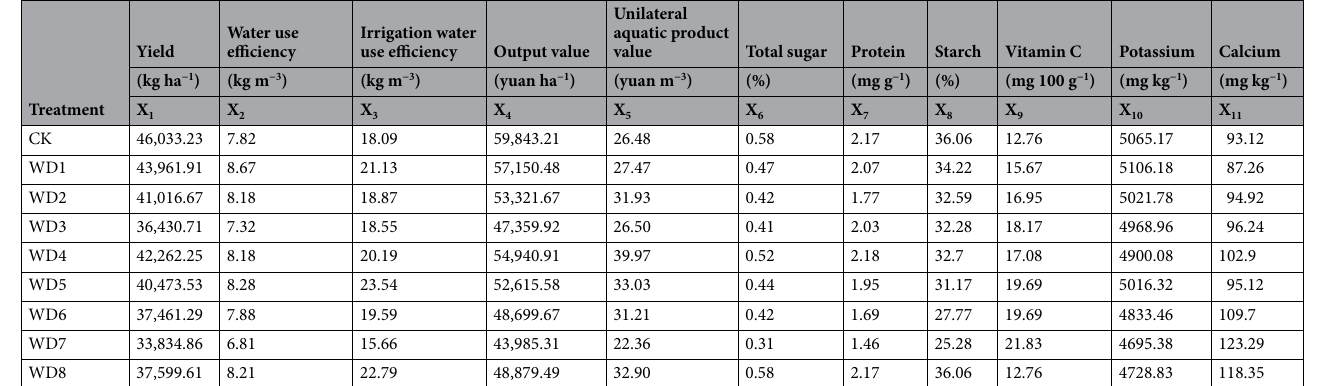
Table 4. Indices used to evaluate potato in conventional irrigation (CK) and regulated deficit drip irrigation treatments. The irrigation treatments were conventional irrigation (CK) and mild or moderate water deficit during each of four stages of potato growth. Mild deficit was in treatments WD1 (seedling), WD2 (tuber initiation), WD3 (tuber bulking), and WD4 (starch accumulation); moderate deficit was in treatments WD5 (seedling), WD6 (tuber initiation), WD7 (tuber bulking), and WD8 (starch accumulation).